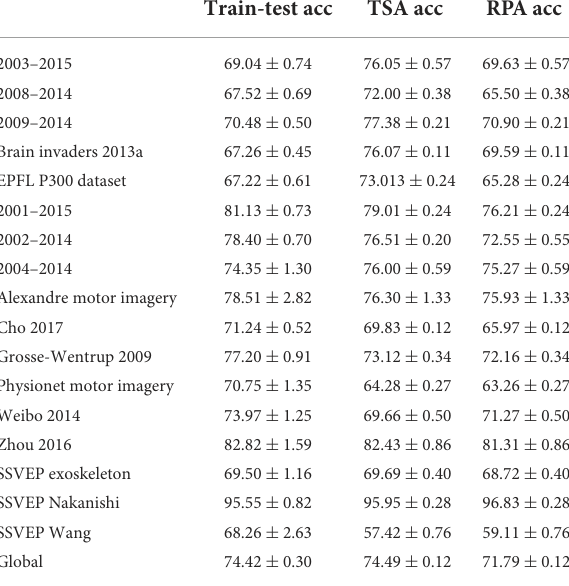
TABLE 3 Balanced accuracy ± standard error for the good subjects of each dataset averaged over number of alignment trials, target and source for train-test, TSA, and